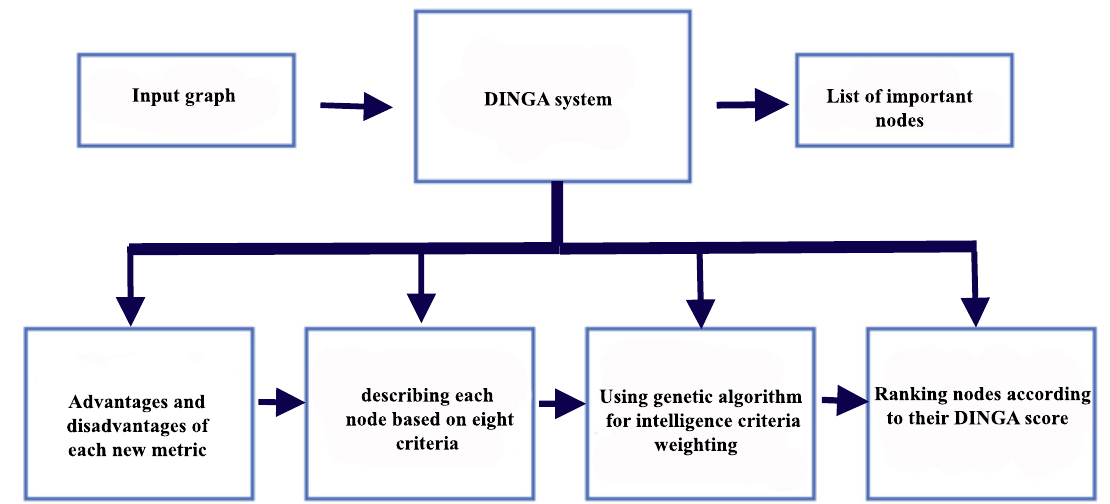
Figure 1. The proposed DINGA method to discover the important nodes in social networks. The DINGA system returns the list of important people as the output by receiving the social network graph as the